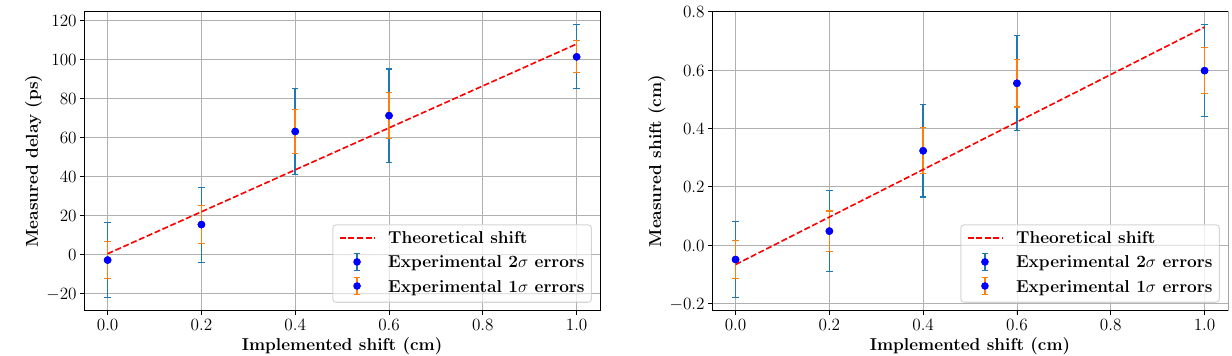
Figure 6. Range shift sensitivities obtained with a PMMA target including an air cavity ranging from 3 to 4 cm, and irradiated with 63 MeV protons. On the left, the proton range shift measured with the PGT technique in unit of time is compared to the actual shift implemented in the phantom. On the right, the PGTI reconstruction allows measuring the proton range shift directly in the space domain. The dashed red line corresponds to the theoretical correlation between the implemented shift and the measured parameter as obtained from MC simulation using the Geant4.10.4.p02 toolkit with the QGSP-BIC-EMY physics list and the UNIFIED model. Error bars represent the 1 σ (orange) and 2 σ (blue) statistical errors obtained by the bootstrap technique (see the Methods section). With both techniques, the TIARA detection module (1 cm 3 PbF 2 crystal coupled to a 3 mm 2 SiPM and placed at 90 ◦ from the beam direction) permits to achieve a proton range shift sensitivity of 4 mm at 2 σ with a statistics of approximately 600